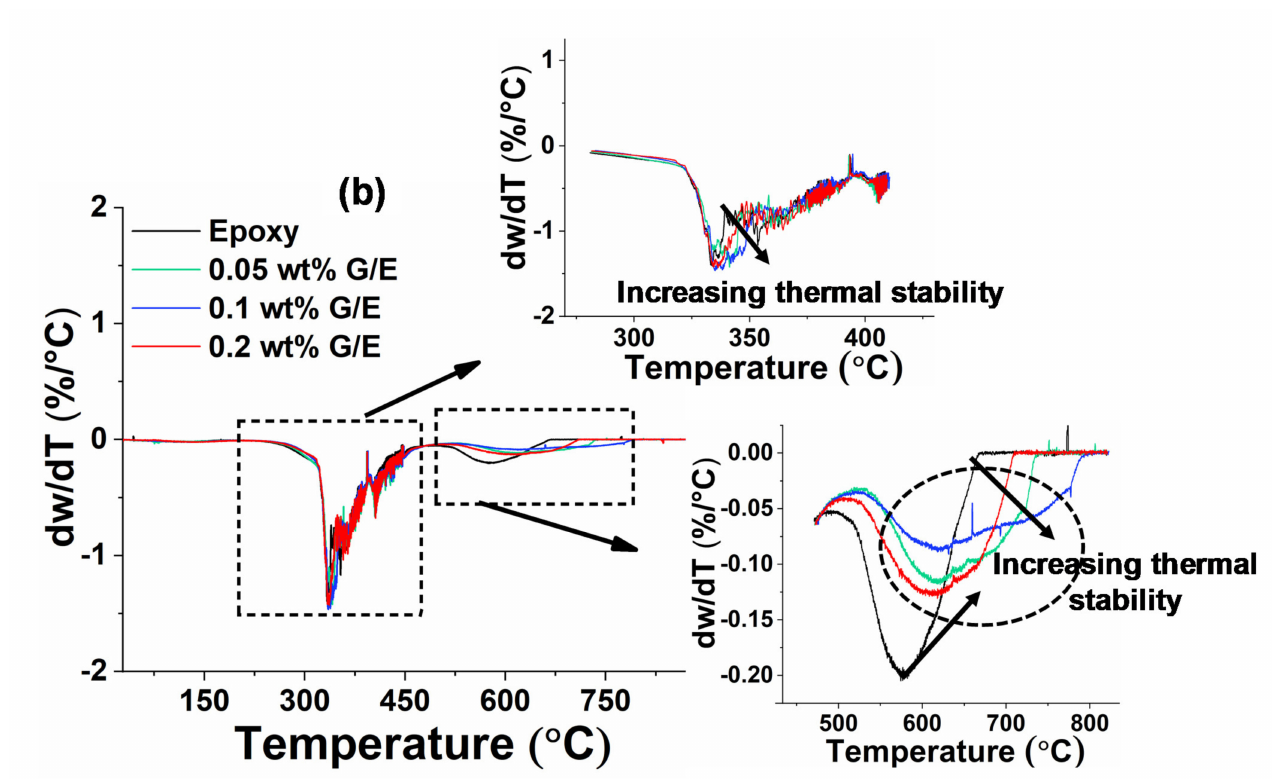
Figure 14. ( a ) TGA curves with zoomed section and ( b ) derivative of TGA with zoomed areas of